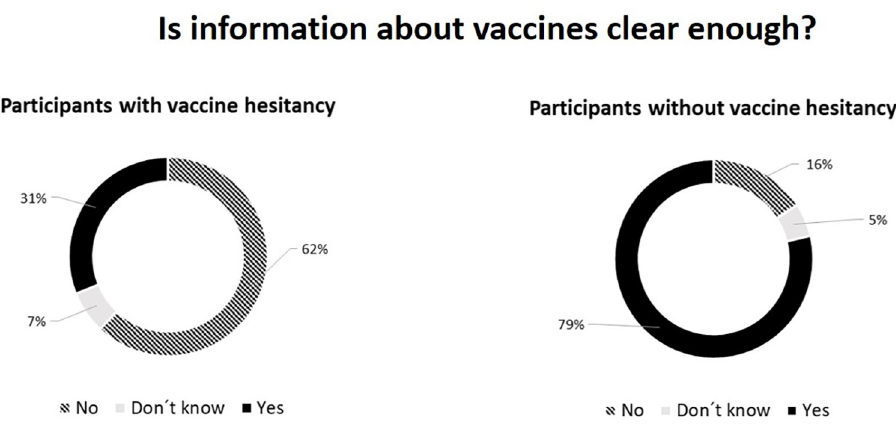
Fig 1. Clarity perceived about vaccine information between hesitant and non-hesitant (N =